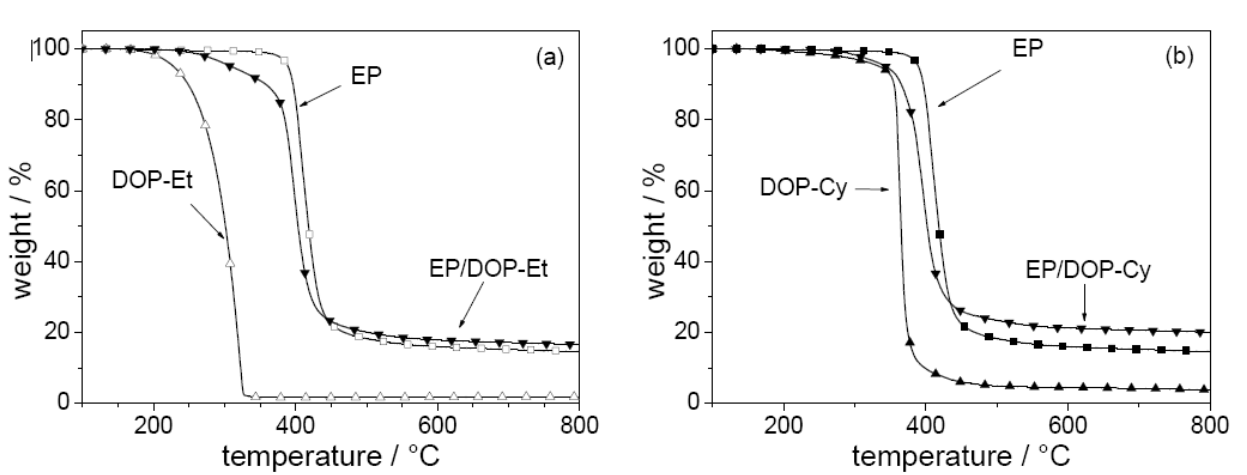
Figure 7. Mass (thermogravimetry under nitrogen; heating rate = 10 Kmin -1 ) of a) EP, DOP-Et, and EP/DOP-Et and b) EP, DOP-Cy, and EP/DOP-Cy.